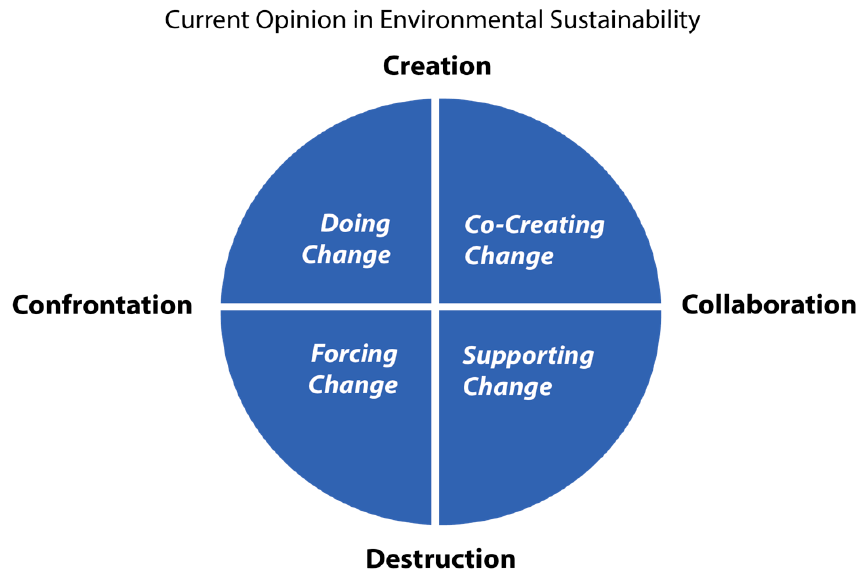
Figure 4. Change quadrants (adopted from [75], p. 9, presented in [80,81]). Processes 2021 , 9 , x FOR PEER REVIEW